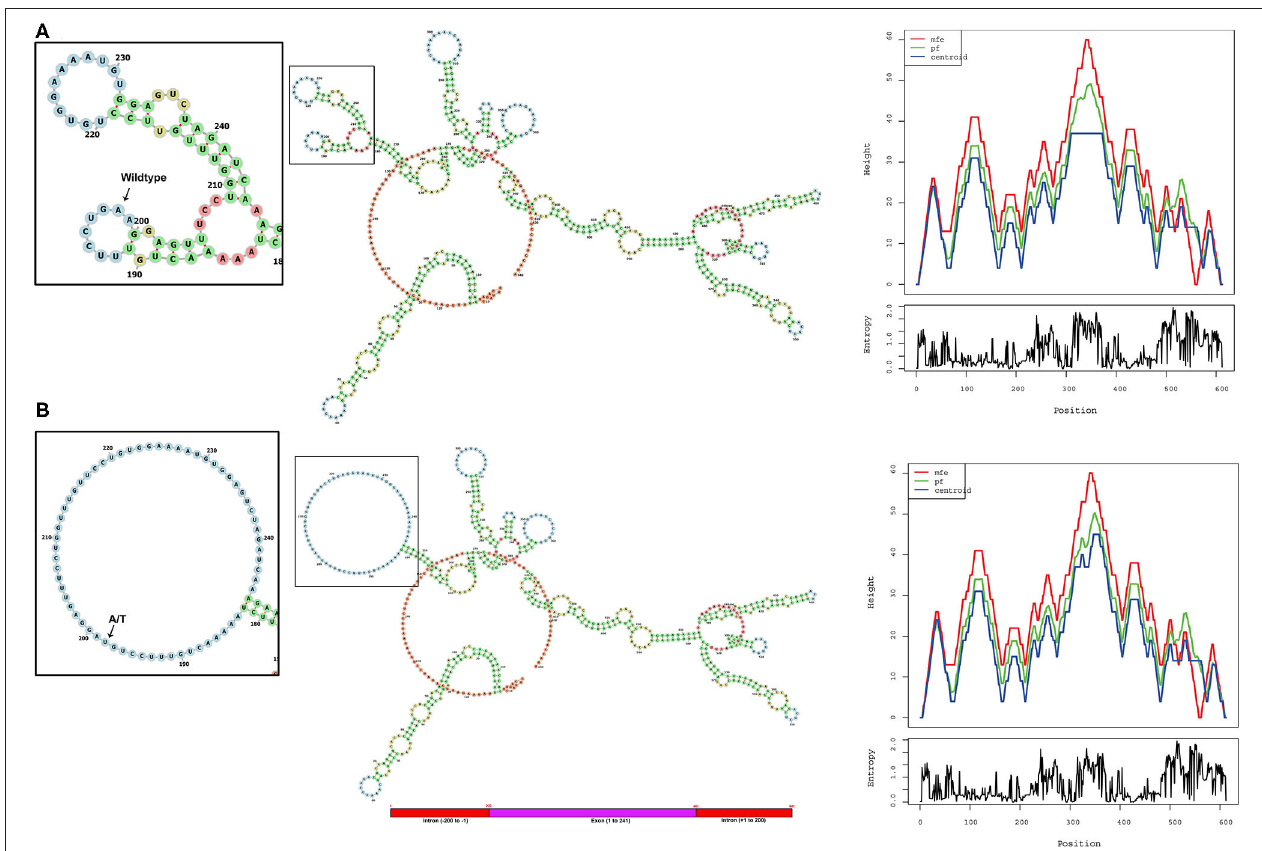
FIGURE 3 | Computational analysis and the RNA secondary structure predictions. The secondary structure predictions of (A) native and (B) variant RNA structures of ALMS1 using RNAfold software. Inset shows the enlarged picture of the region containing the native or the variant part of the RNA. Base-pair probability is indicated in the key. Mountain plot shows the secondary structures in a height vs. position, where the helices are represented in slopes, loops in plateaus, and hairpin loops in the